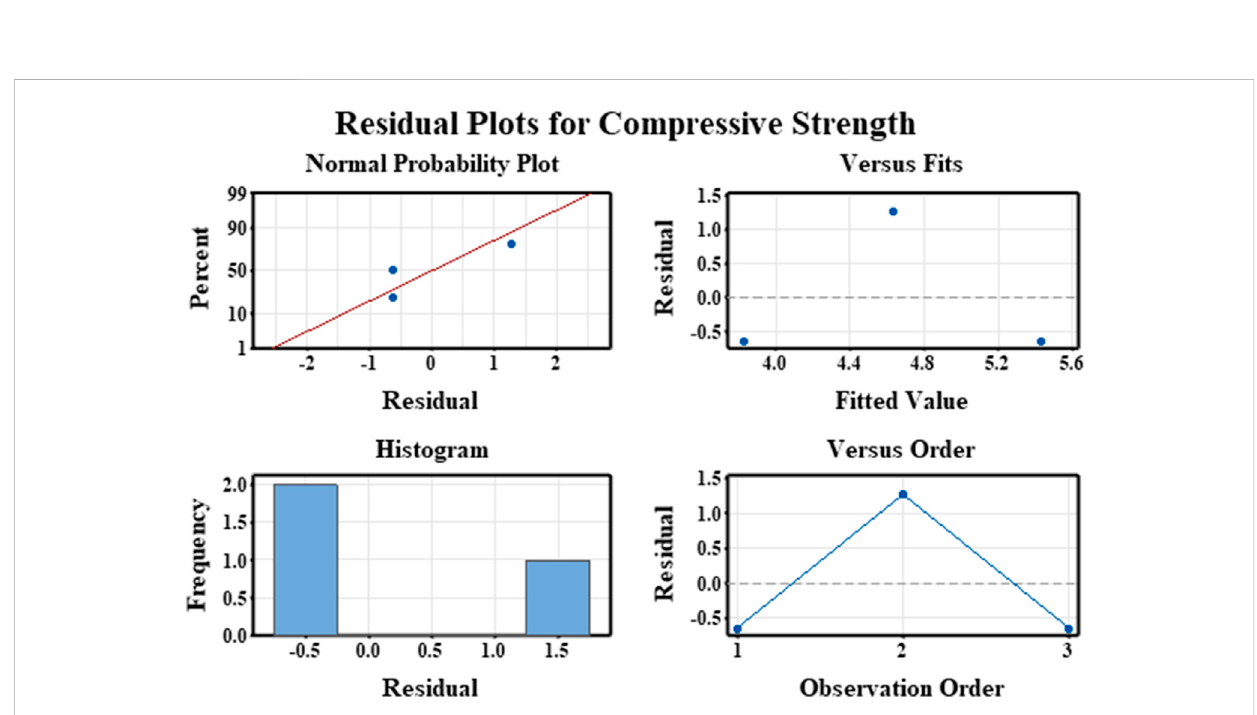
FIGURE 6 Residual plots for compressive